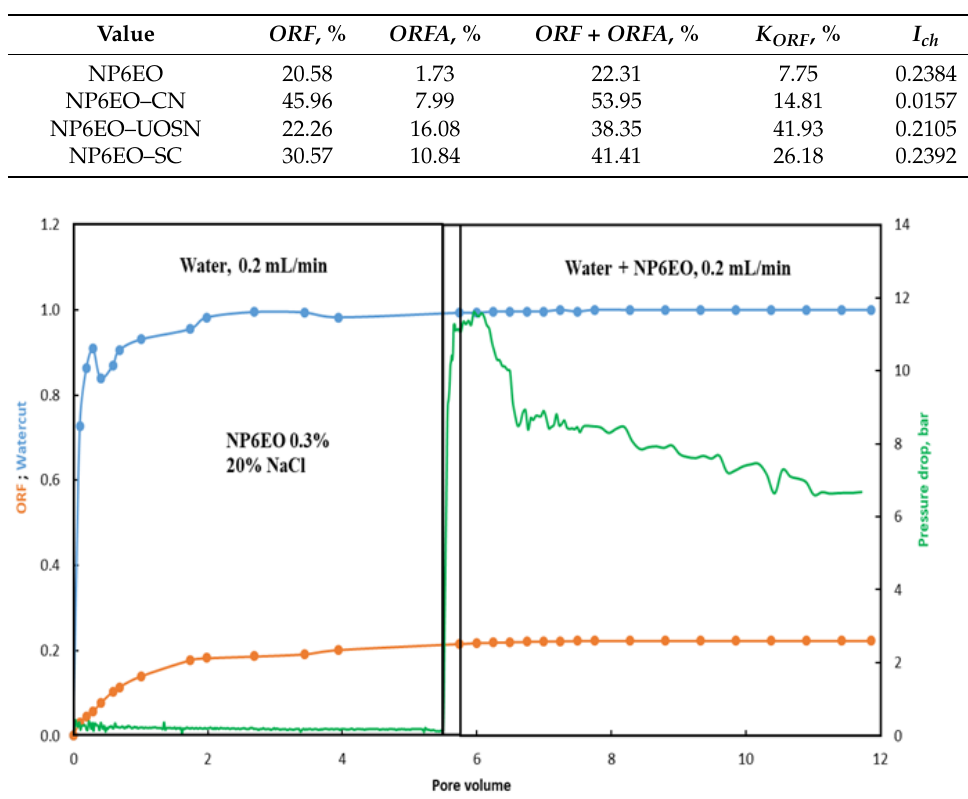
Table 4. The results of experiments.